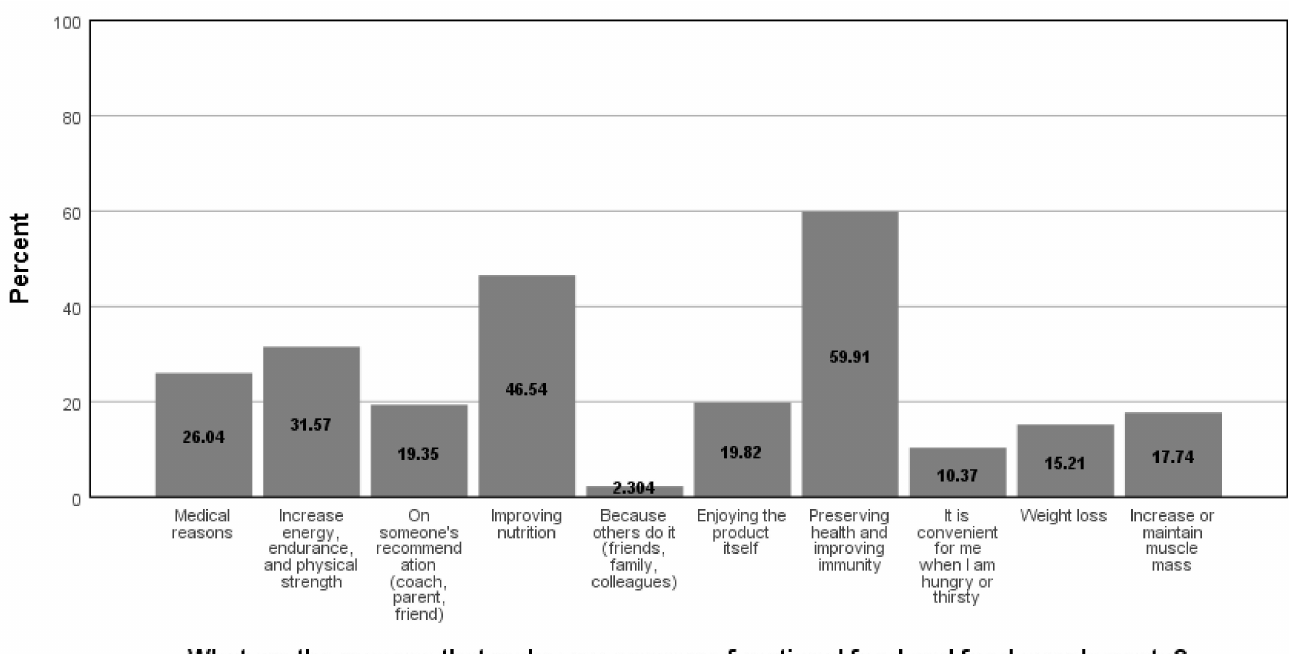
Figure 3. Reasons for functional food and food supplements